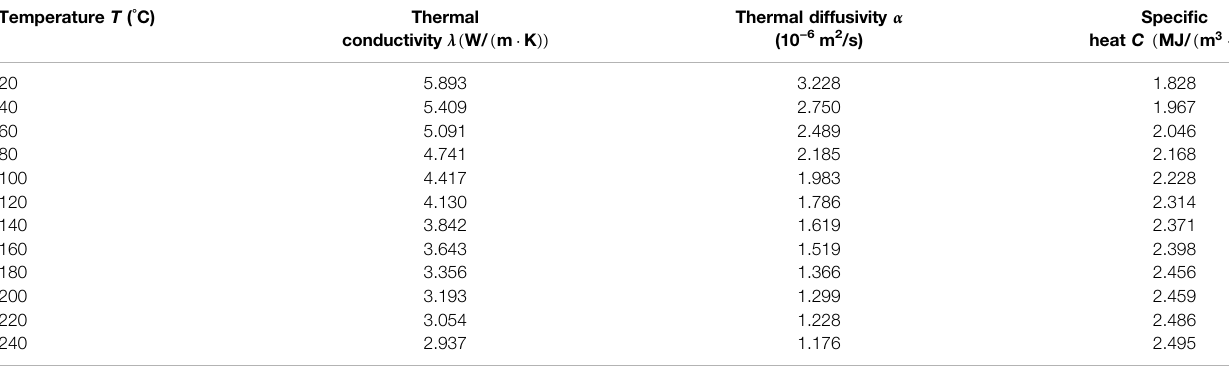
TABLE 3 | Test results of thermal parameters of polycrystalline salt